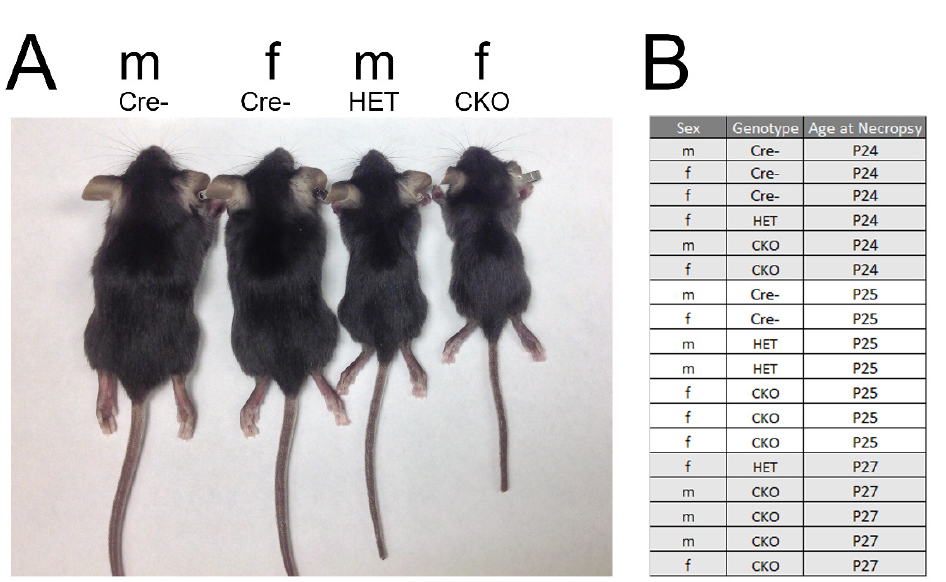
Figure 1. Representative mice used in the pathology analyses. ( A ) Images of male (m) and female (f) Cre-, HET, and CKO mice. ( B ) The sex, genotype, and age of mice used in the evaluation. Five Cre-, four HET, and nine CKO mice were analyzed. M: male; F: female.